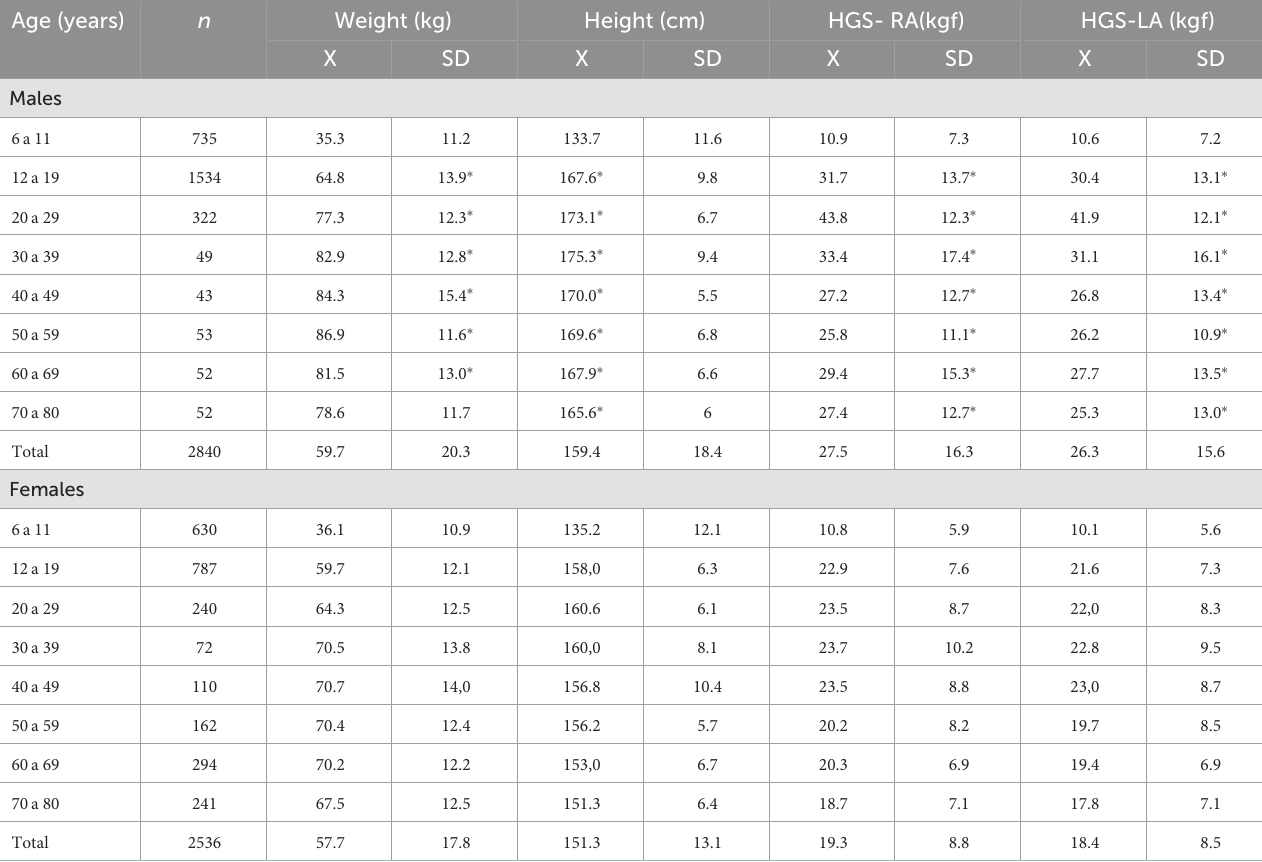
TABLE 1 Characteristics of the sample